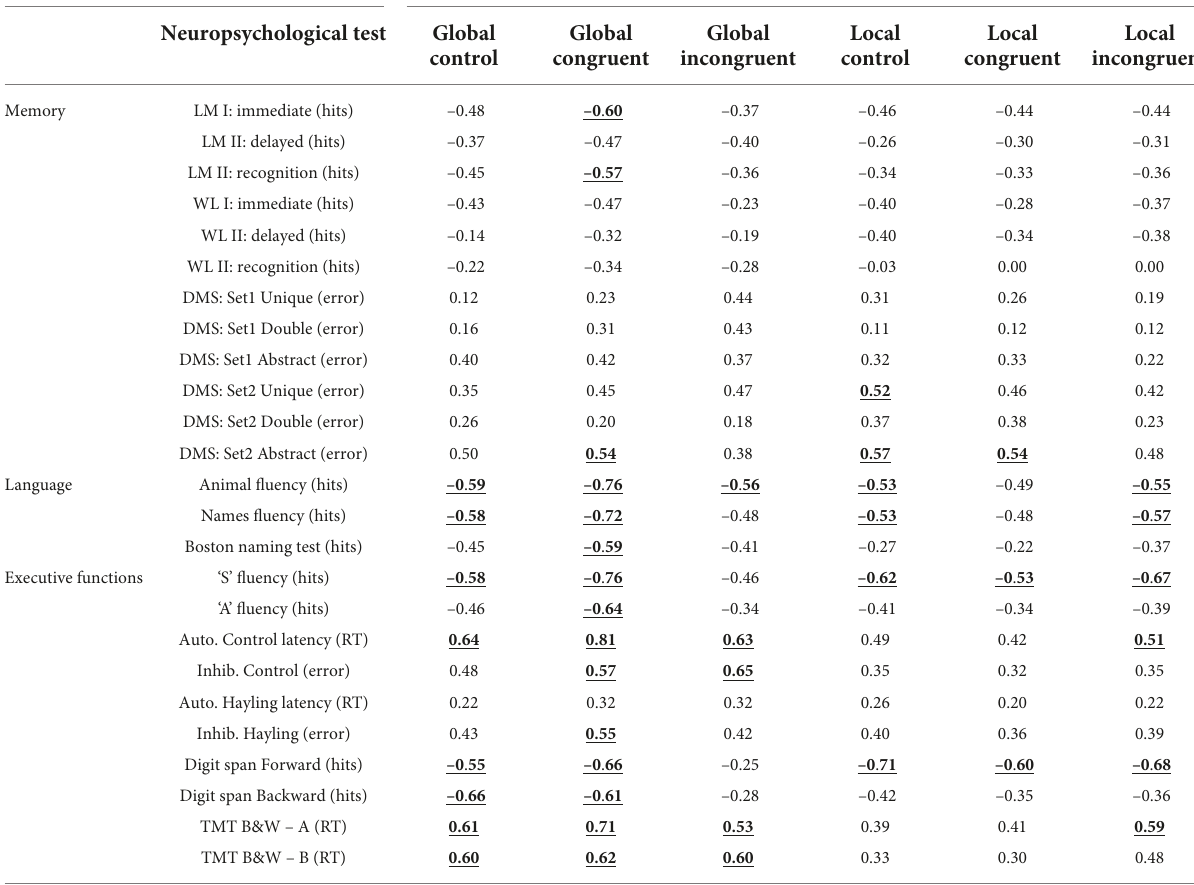
TABLE 6 Results of Spearman correlations between neuropsychological variables and the different conditions of the Navon task. Cognitive